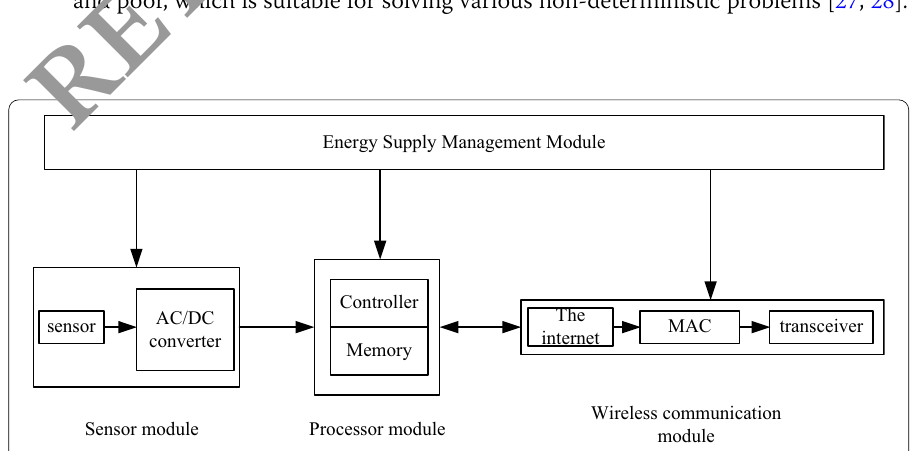
Fig. 3 Organizational structure diagram of sensor